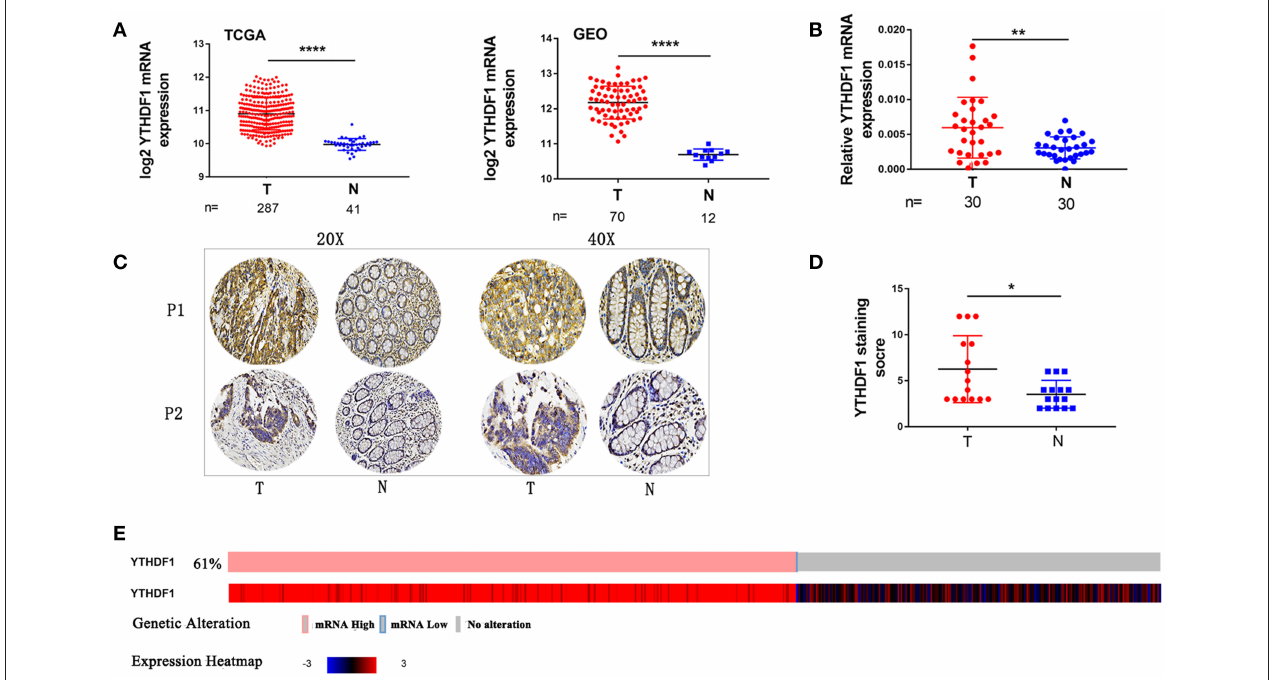
FIGURE 1 | YTHDF1 Is Overexpressed In CRC. (A) YTHDF1 mRNA levels in the TCGA (left) and GEO (right) databases. (B) YTHDF1 mRNA expression in CRC tissues (T) and adjacent normal tissue (N). (C) Representative IHC images of YTHDF1 protein expression in CRC tissues (T) and adjacent normal tissue (N) of two patients (P1–P2). (D) Quantification of the IHC score of YTHDF1 in CRC tissue (T) and adjacent normal tissue (N). (E) 61%(321/524) CRC patients/samples with the increase in YTHDF1 expression in TCGA. (* p < 0.05; ** p < 0.01; *** p < 0.001; **** p < 0.0001).